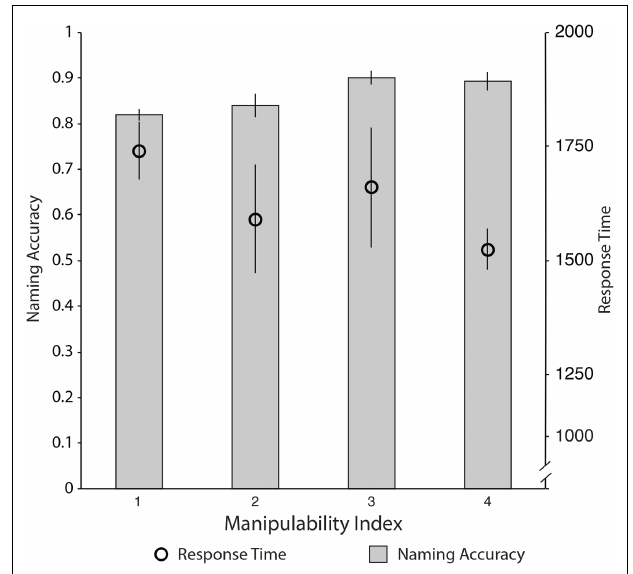
FIGURE 7 | CaseAA’s naming accuracy and response time of Snodgrass andVanderwart stimuli as a function of Manipulability Index from Magnie et al. (2003).